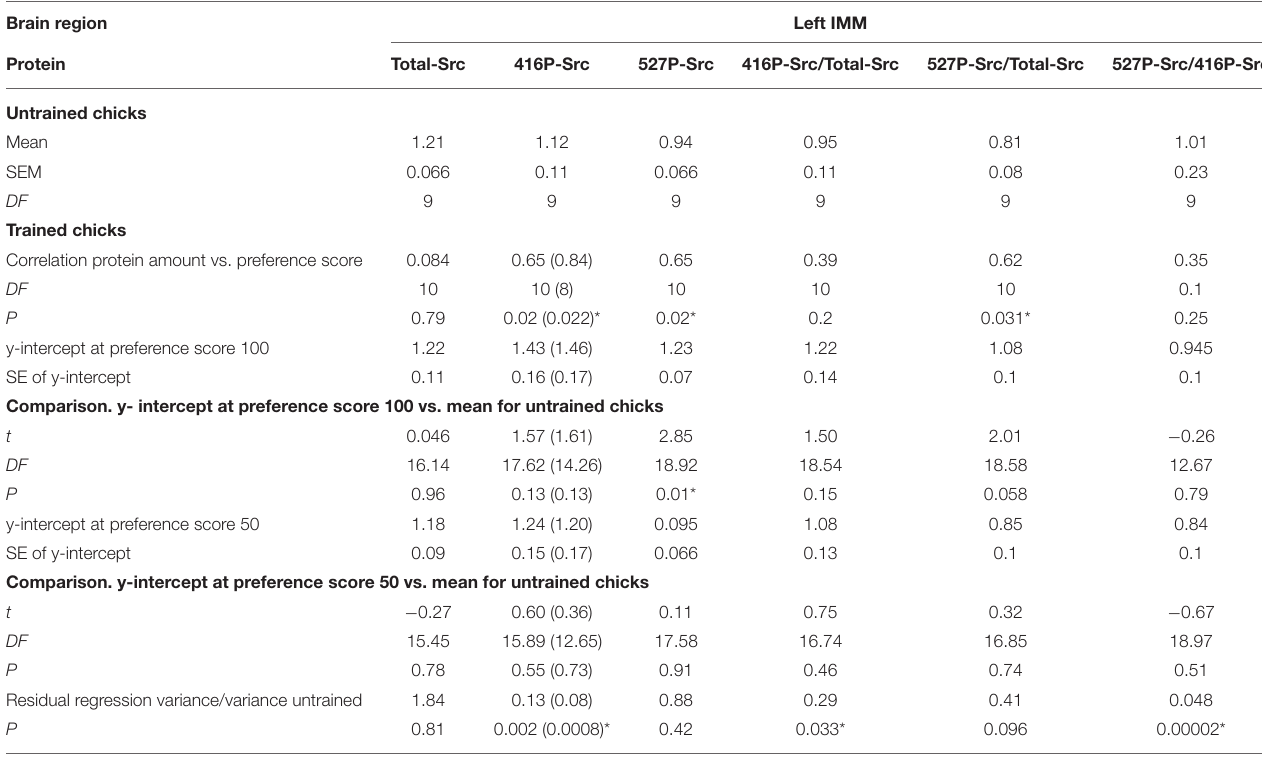
TABLE 1 | Standardized relative amount of protein. Brain region